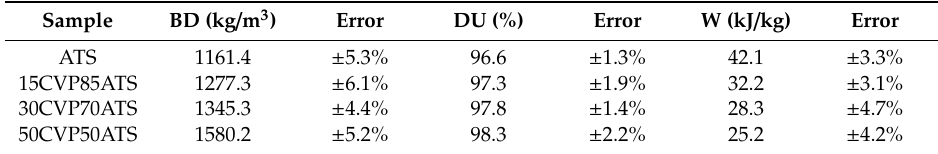
Figure 4. ( a – c ) Energy consumption of the CSB pellet, and ( d ) co-pelletization interaction of ATS and CVP. Table 2. Sample physical properties under parameters of temperature (120 °C), pressure (100 MPa), and moisture content (10%).